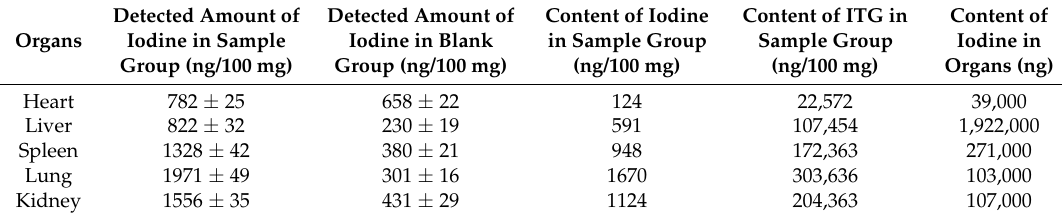
Table 8. The content of iodine and ITG in rat